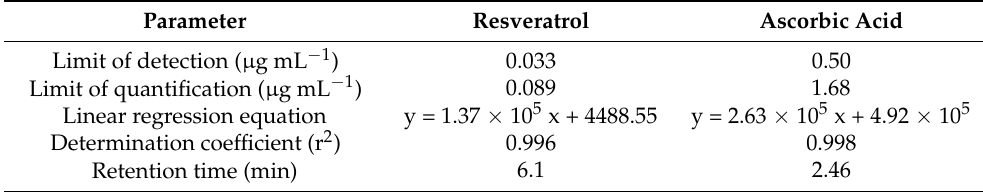
Table 1. Statistical parameters for the chromatographic analysis of resveratrol and ascorbic